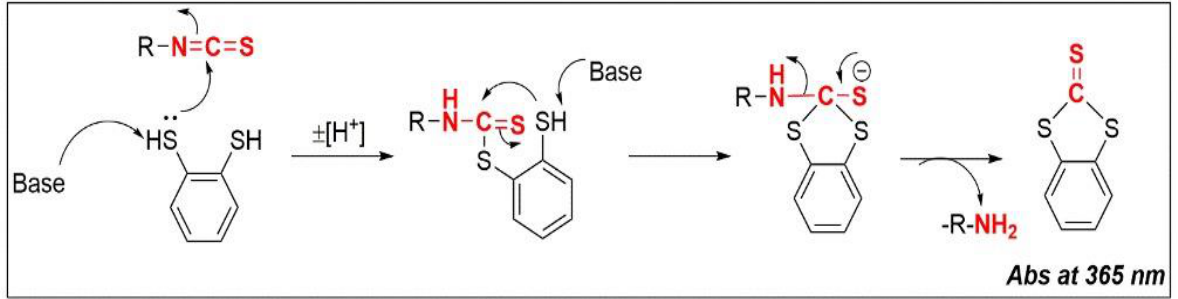
Figure 6. The cyclo-condensation assay is used for the quantification of ITCs. Briefly, it involves the nucleophilic attack of both vicinal thiols of 1,2-benzenedithiol into the electrophilic carbon atom of ITC, leading to the formation of a stable 1,3-benzodithiole-2-thione product which absorbs at 365 nm.